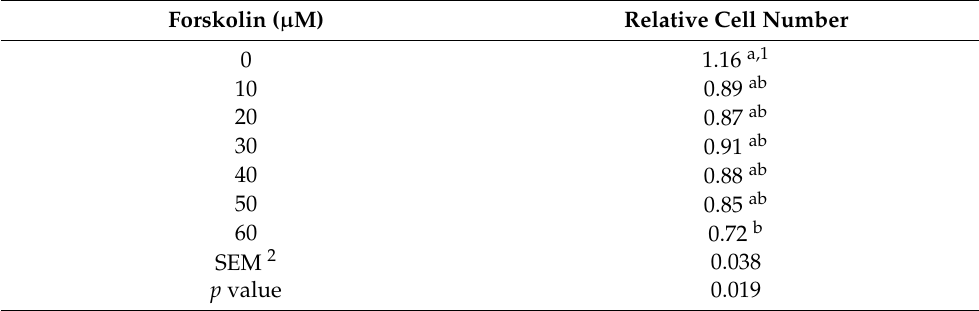
Figure 3. Effect of forskolin on adipocytes of high-fat diet-induced obesity in mice. ( a ) Hematoxylin and eosin staining of the subcutaneous and gonadal fat tissue of mice fed on high-fat diet in response to forskolin treatment. Three mice samples per group (n = 3) were stained and one representative result is shown. Bars indicate a length of 100 µ m. ( b ) Effect of forskolin on the fat cell diameter of diet-induced obesity in mice. Subcutaneous and gonadal adipose section from three mice samples per group (n = 3) were measured. The bars indicate mean ± SD. a,b Means with no common superscript are significantly different ( p ≤ 0.05). Table 2. Dose-dependent cytotoxicity of forskolin on C3H10T1/2 mesenchymal stem cells.